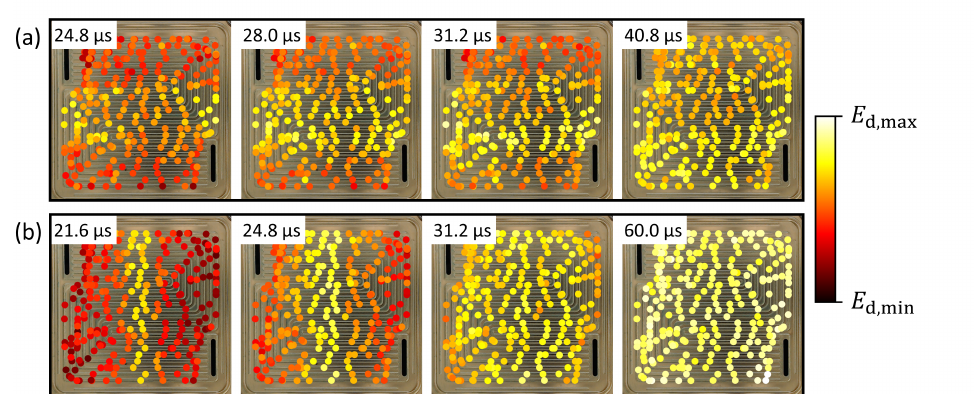
Figure 7. Change in the signal energy of the difference signal E d over time. E d is shown for the windows of the difference signal. Each window is 3.2 µs long, the timestamps in the figure mark the beginning of each window. ( a ) Signal transmitted from PWAS 2 to PWAS 1, ( b ) signal transmitted from PWAS 4 to PWAS 3. The colors indicate the value of E d relative to the minimum and maximum values for each signal